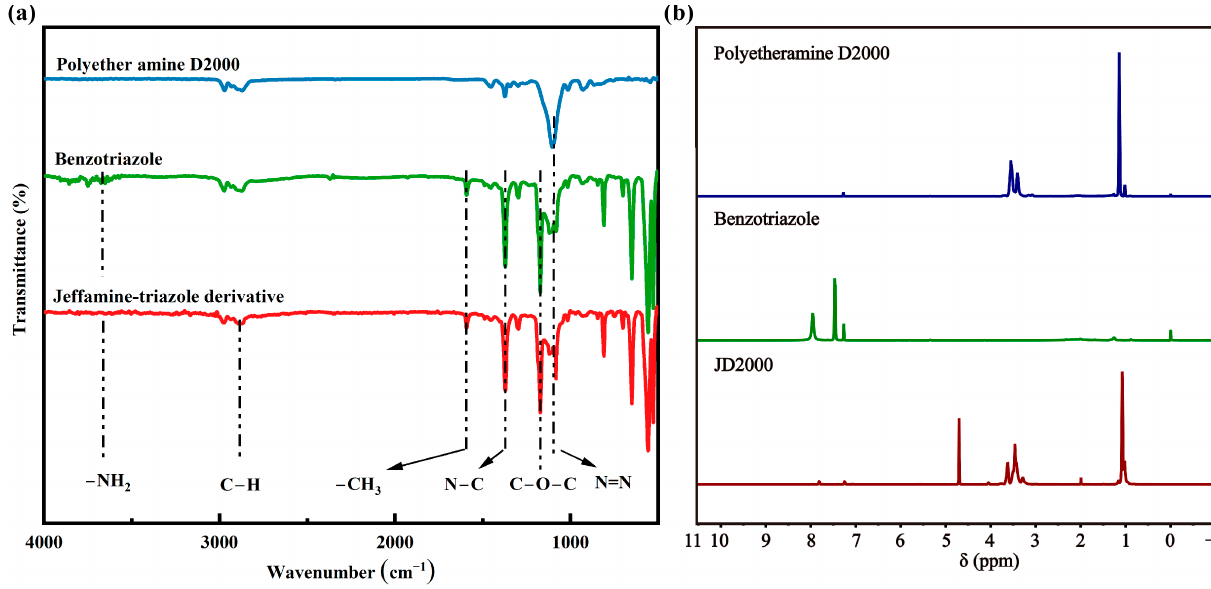
Figure 2. The ( a ) FTIR and ( b ) 1 H NMR spectra of the JD2000. The structure of the JD2000 product was analyzed using mass spectrometry, as shown in Figure 3. The peak at 2334 m / z is the derivative of Jeffamine-triazole at n = 34. The disparity of m / z between the adjacent peaks is approximately 58, which represents the difference of a –C 3 H 6 O structure. GPC results are shown in the inset’s table. The number average molecular weight (Mn) is 1055, and the weight average molecular weight (Mw) is 2234. The degree of dispersion (Mw/Mn) is 2.117. It can be seen that the molecular weight of the JD2000 is concentrated around 2234, and the main degree of polymerization is 34. The results show that the synthesized product had a polyether chain structure and was a mixture of derivatives with different degrees of